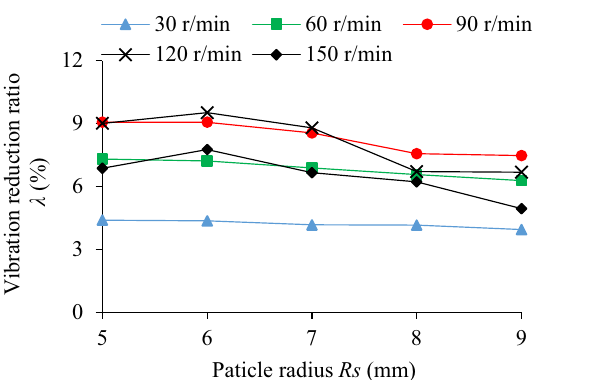
Figure 7. Influence of R S on VRR.